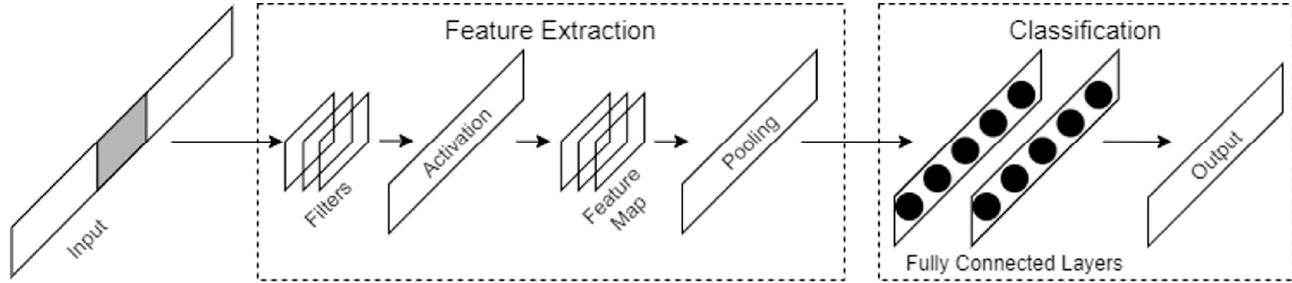
Figure 1. A basic CNN architecture.